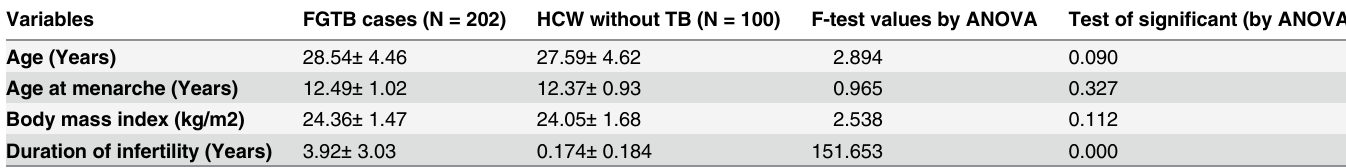
Table 2. Association of demographic findings among infertile women with female genital tuberculosis (FGTB) and healthy control women (HCW) without tuberculosis (TB).